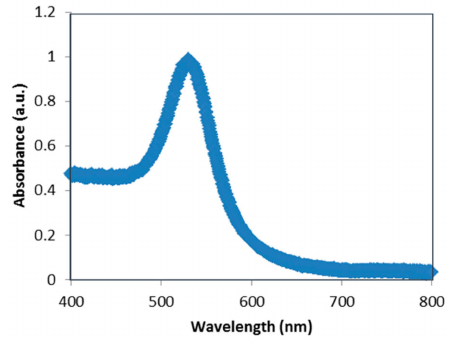
Figure 1. Absorption spectrum of GNPs stabilized suspension in citrate